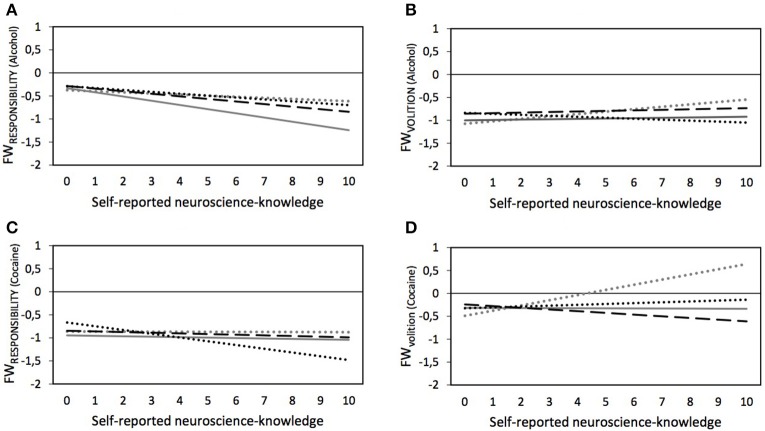
Predicted values for FWRESPONSIBILITY and FWVOLITION regarding people with addiction to alcohol (A,C) or cocaine (B,D) depending on experimental splits (… dotted gray lines, control group; — drawn gray lines, ”Text-only”; – – dashed black lines, “Text and neuroimage”; … dotted black lines, “Neuroimage-only”) and self-reported neuroscience-knowledge – based on Models 1 through 4 in Table 5, plotted for females without SUD, and subsample-specific average age, average education, and average BLRS.